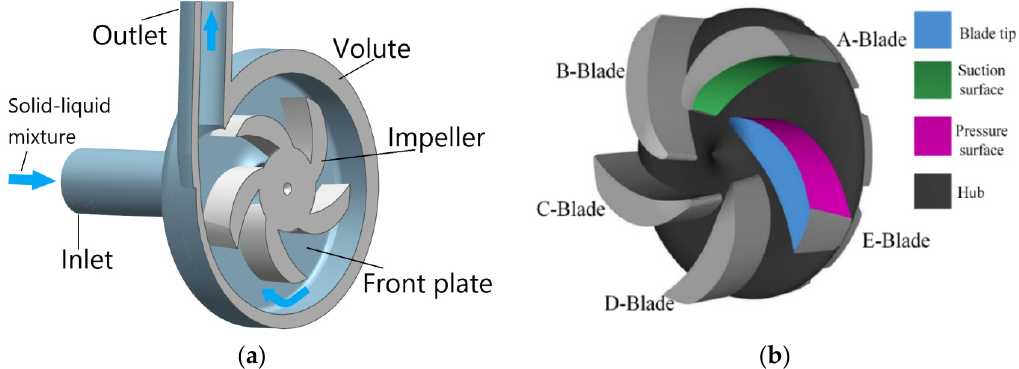
Figure 1. Schematic diagram of centrifugal pump: ( a ) pump; ( b ) impeller.